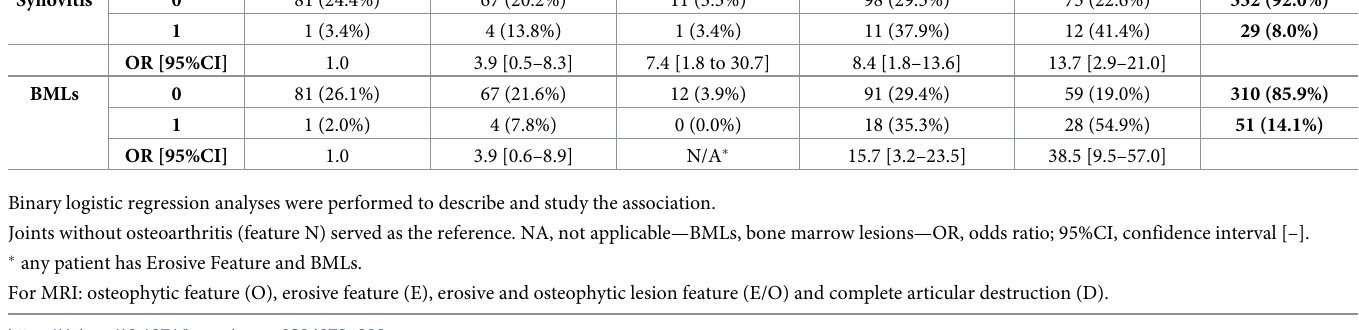
Table 6. The agreement and the ORs (95% CI) between MRI features and synovitis, BMLs of the interphalangeal joints of the 2nd–5th fingers. Features